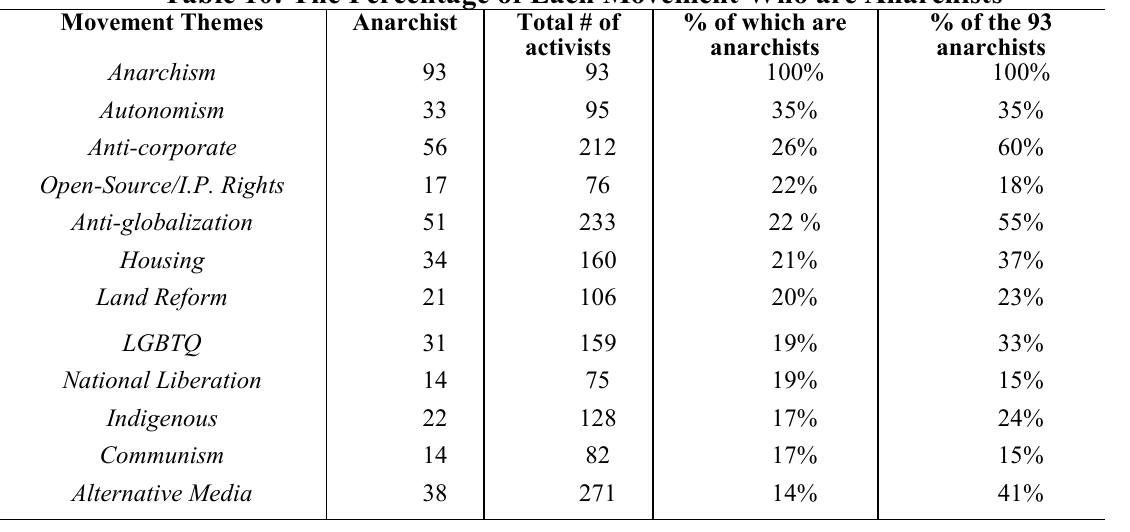
Table 10: The Percentage of Each Movement Who are Anarchists Movement Themes Anarchist Total # of % of which are % of the 93 activists anarchists anarchists Anarchism 93 93 100%